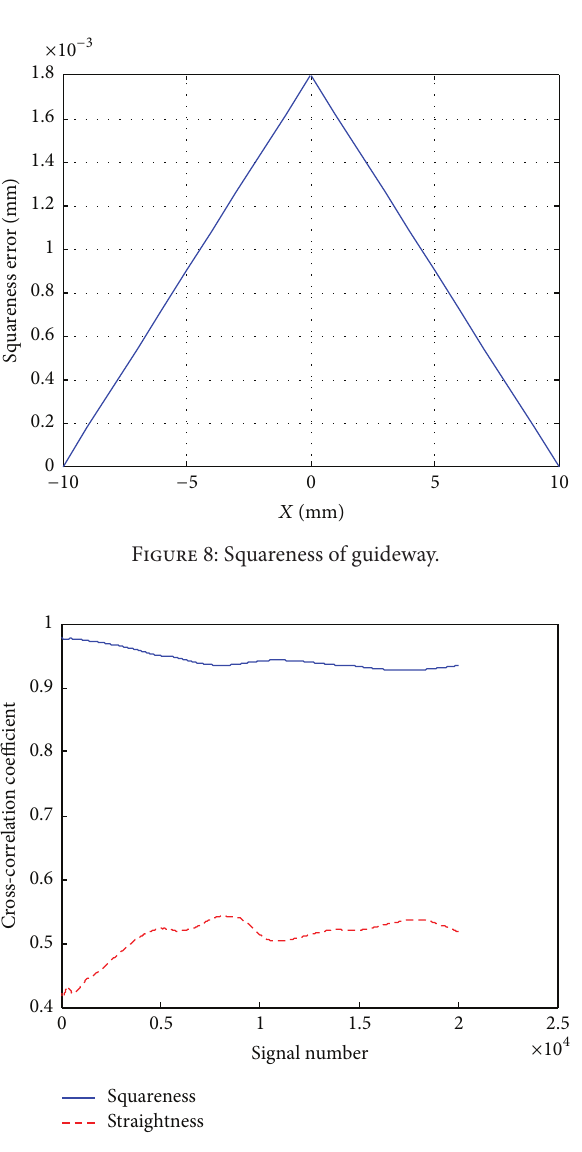
Figure 9: Cross-correlation analysis between surface topography and guideway